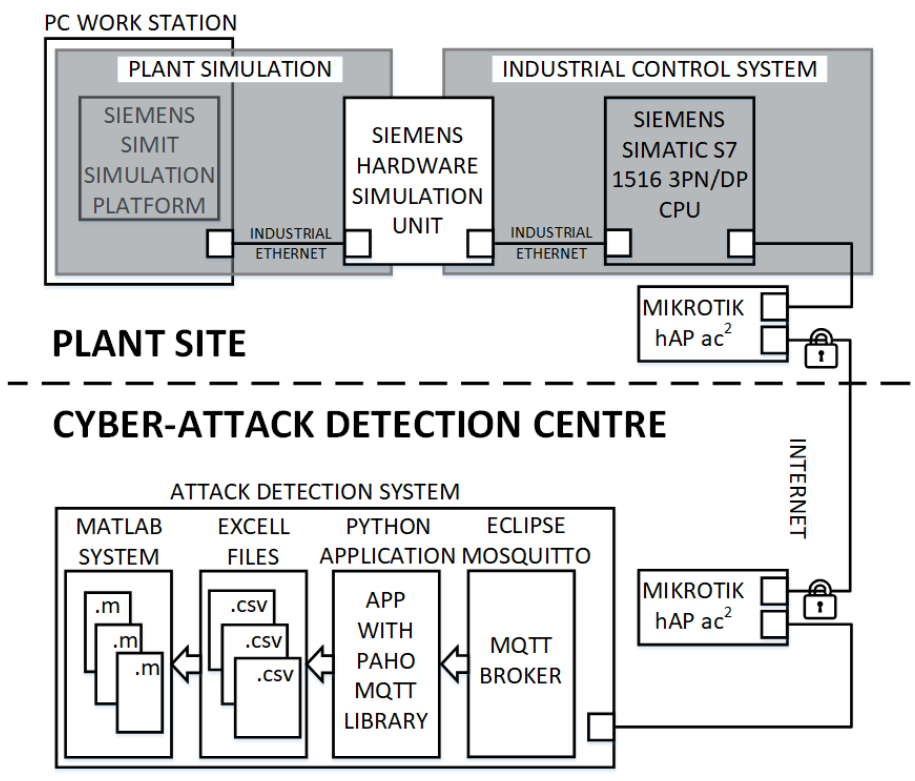
Figure 2. Distributed laboratory setup based on outsourcing idea.